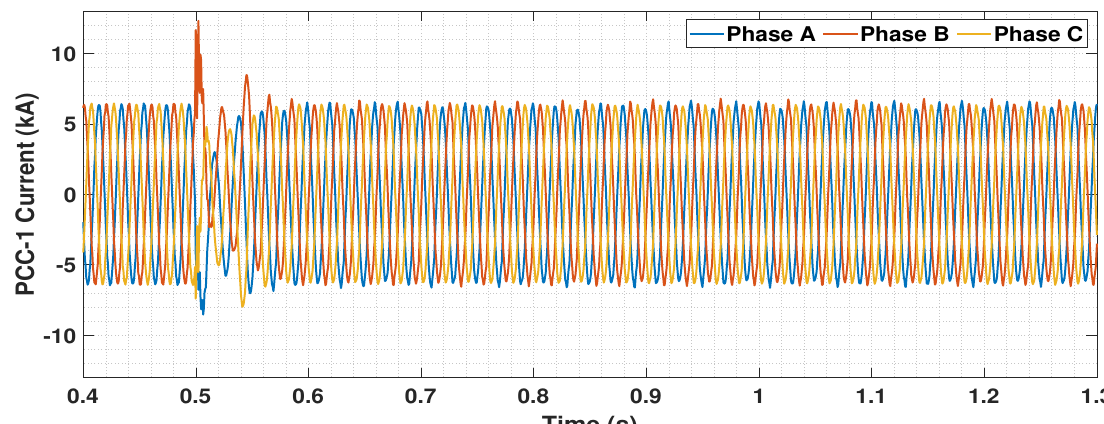
Figure 36. Currents in PCC-1 upon three-phase line to ground fault in the middle of cable-1.